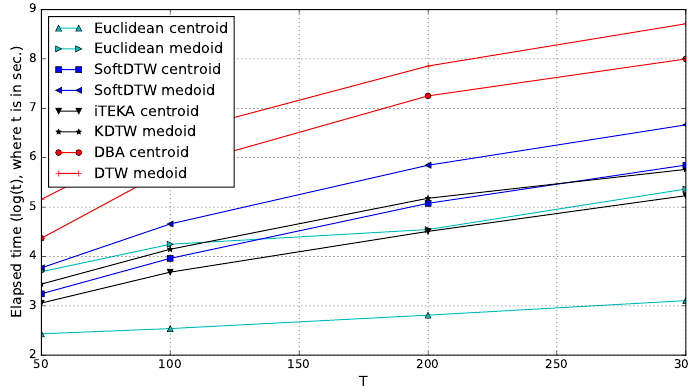
Figure 8. Elapsed processing time as the size of the re-sampled trajectories, T , varies ( T ∈ { 50,100,200,300 }